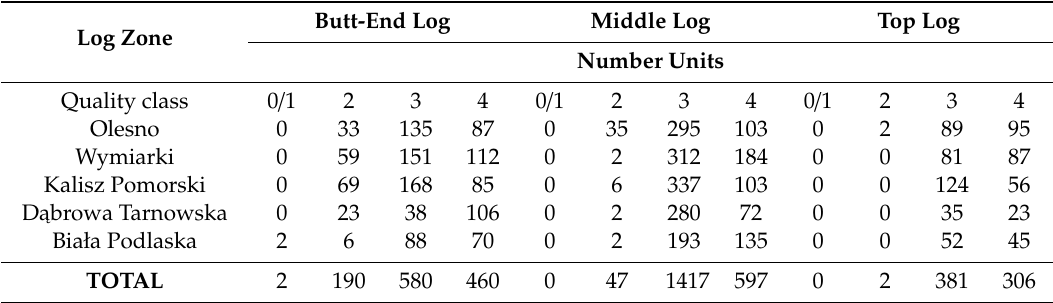
Table 12. The quality grading of coniferous sawn timber according to PN-EN 1611-1 for the various forest divisions. Butt-End Log Middle Log Top Log Number